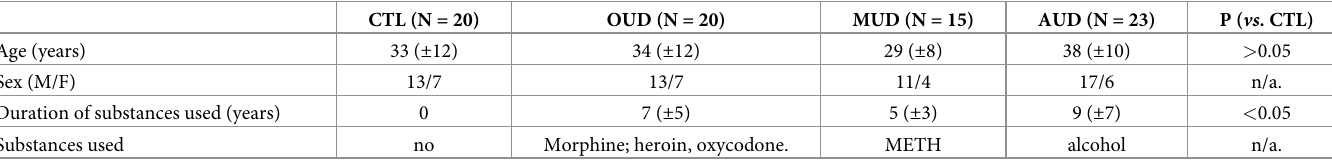
Table 1. Health profile of subjects used in the